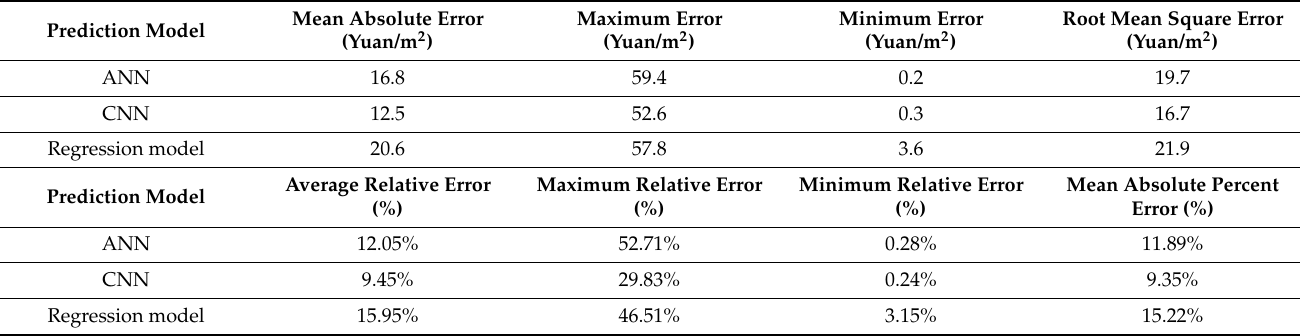
Table 5. Relevant error indicators of the fully-connected ANN model, CNN model prediction, and regression